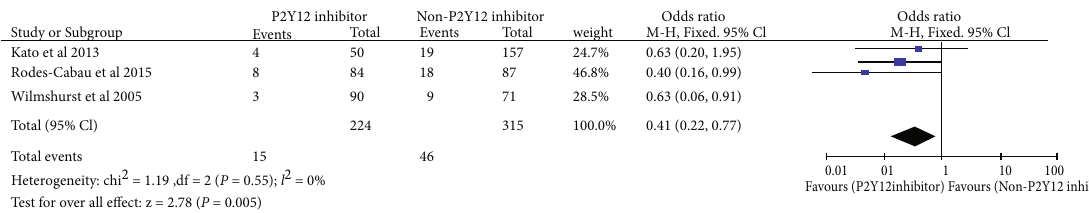
Figure 4: Forest plot of antiplatelet regimens including P2Y12 inhibitors vs. antiplatelet regimens excluding P2Y12 inhibitors in preventing new-onset migraine headaches after transcatheter